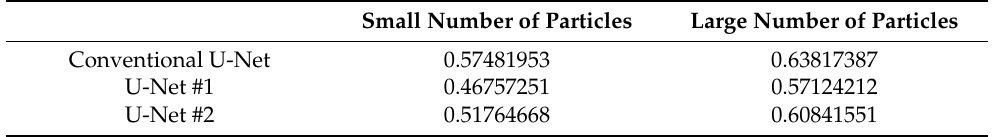
Table 12. F1-score for each network